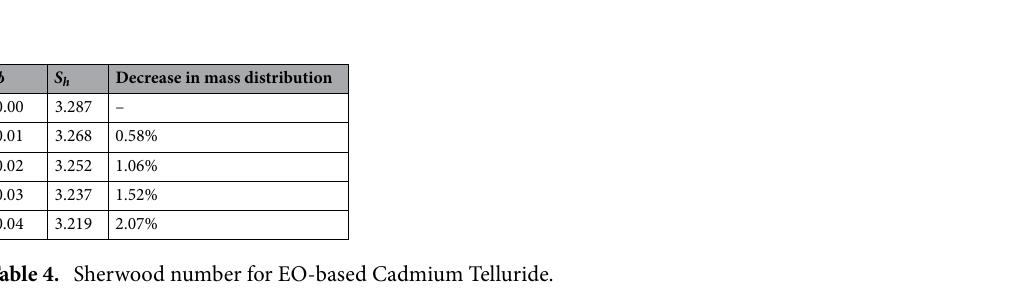
Table 3. Nusselt number for EO based-Cadmium Telluride.